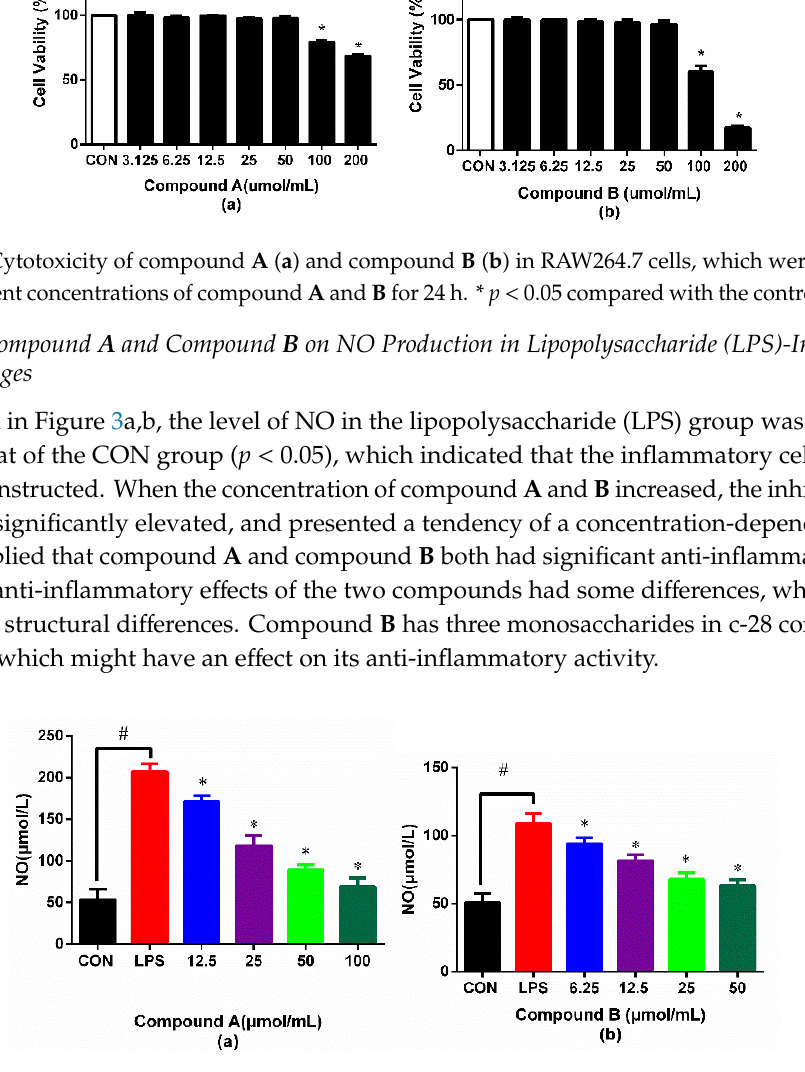
Figure 3. Inhibitory effects of compound A ( a ) and compound B ( b ) on lipopolysaccharide (LPS)- induced NO production in RAW264.7 macrophages. # p < 0.05 compared with the control group; * p < 0.05 compared with LPS group.